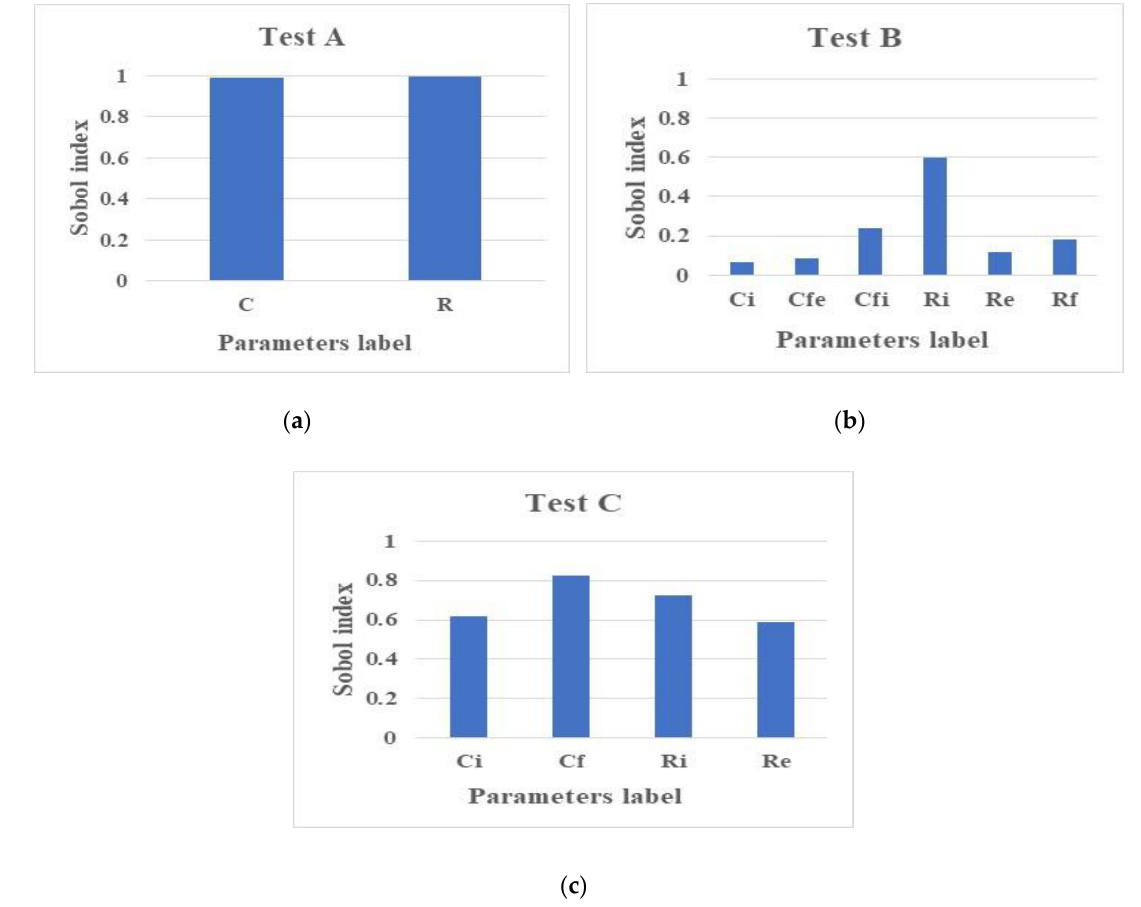
Figure 3. Results of sensibility analysis: ( a )Test A; ( b ) Test B; ( c ) Test C.